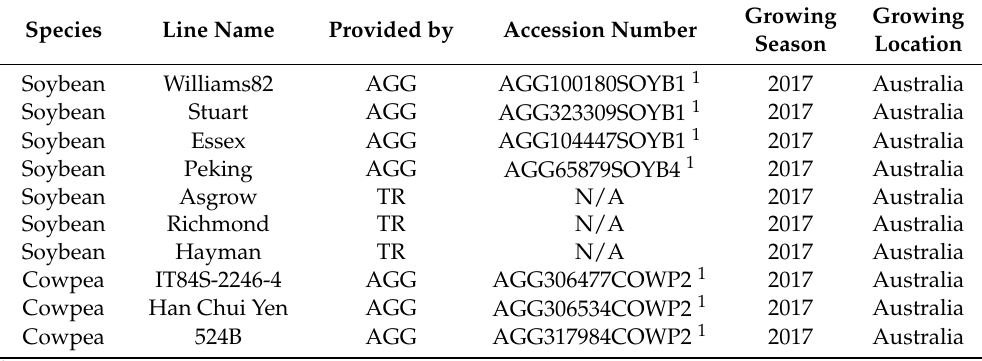
Table 2. List of soybean and cowpea lines used as comparator species for de novo analysis of seed proximate composition. Lines were provided by Australian Grains Genebank (AGG; Australia) and Prof. Terry Rose (TR) from Southern Cross University,